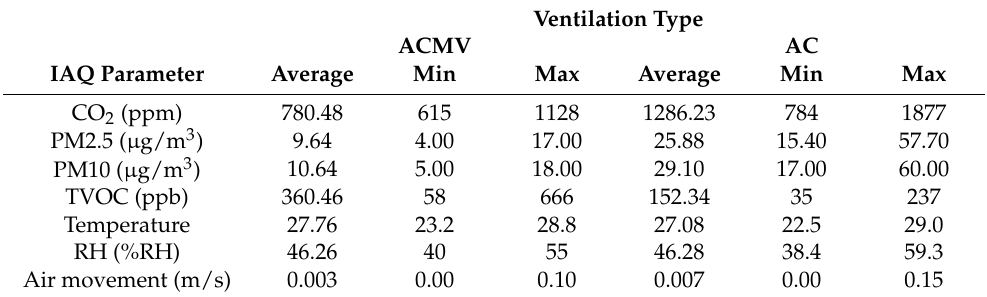
Table 3. IAQ parameters for different types of ventilation in bank vaults.